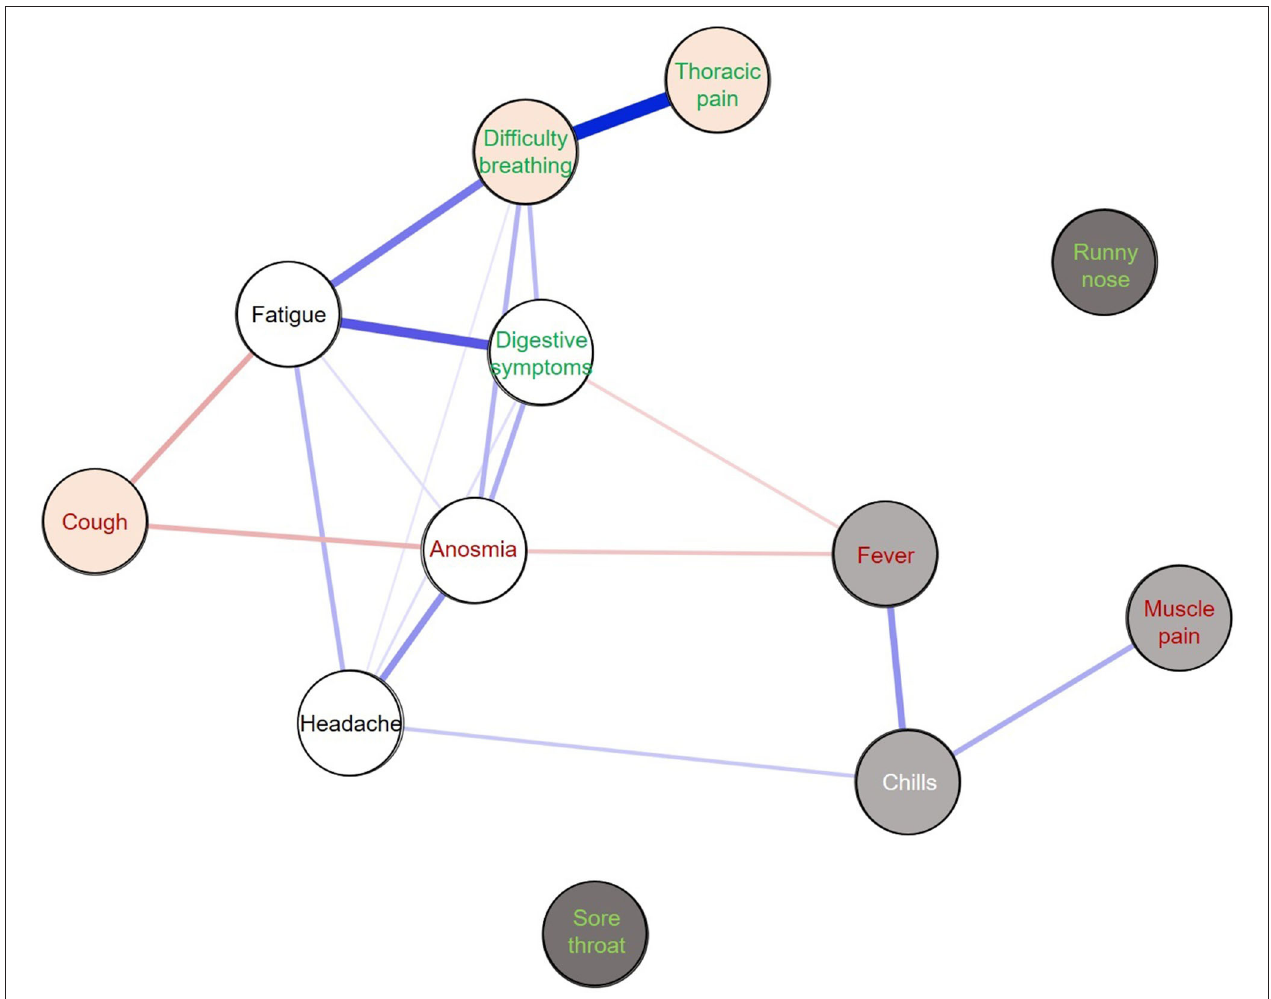
FIGURE 1 | Network of symptoms among positive SARS-CoV-2 RT-PCR tests ( n = 707). The different colored circles correspond to distinct communities: light gray = systemic 1 (“flu-like” syndrome); orange = respiratory symptoms; white = systemic 2. Dark-gray symptoms were not included in any community. Predictive symptoms (multivariate analysis) for a positive RT-PCR test are shown in red and predictive symptoms for a negative RT-PCR test are shown in green. Blue edges correspond to positive links between symptoms and red edges to negative links. The thicker the line, the stronger the